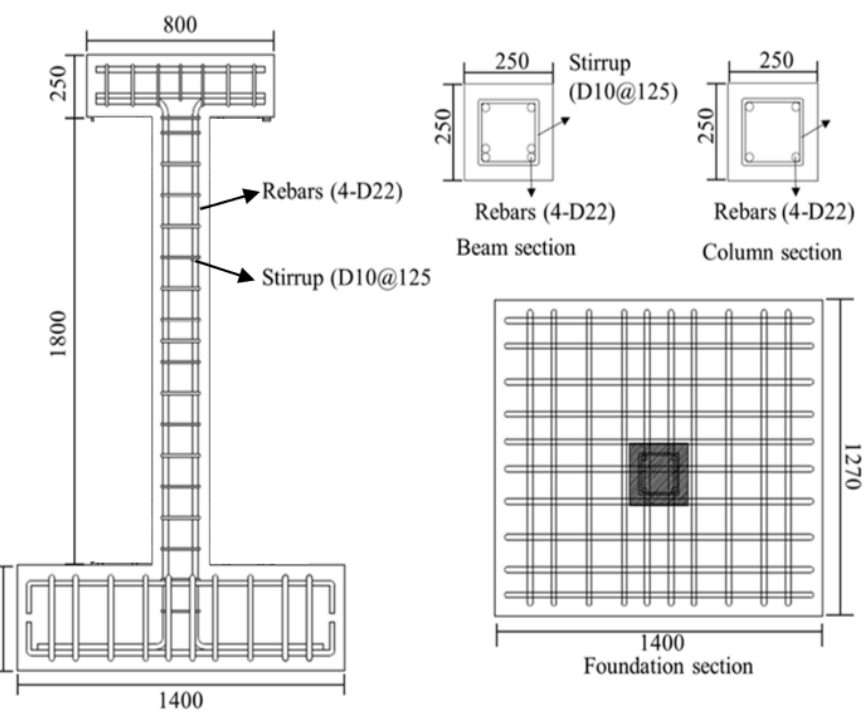
Figure 2. Details of an RC column (m).